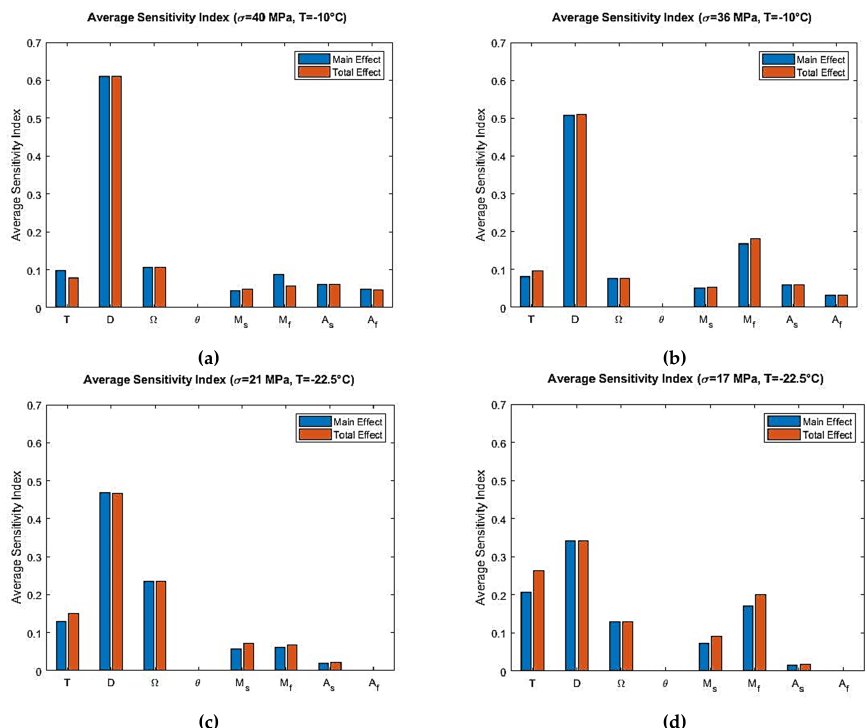
Figure 9. Sobol average sensitivity indices at simulated temperatures and maximum loading stress for the Liang-Rogers model: ( a ) T = − 10 ◦ C, σ max = 40 MPa; ( b ) T = − 10 ◦ C, σ max = 36 MPa; ( c ) T = − 22.5 ◦ C, σ max = 21 MPa; ( d ) T = − 22.5 ◦ C, σ max = 17 MPa. Materials 2019 , 12 , x FOR PEER REVIEW